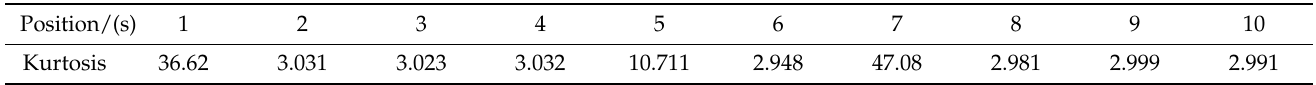
Table 2. The kurtosis values of segment signals.